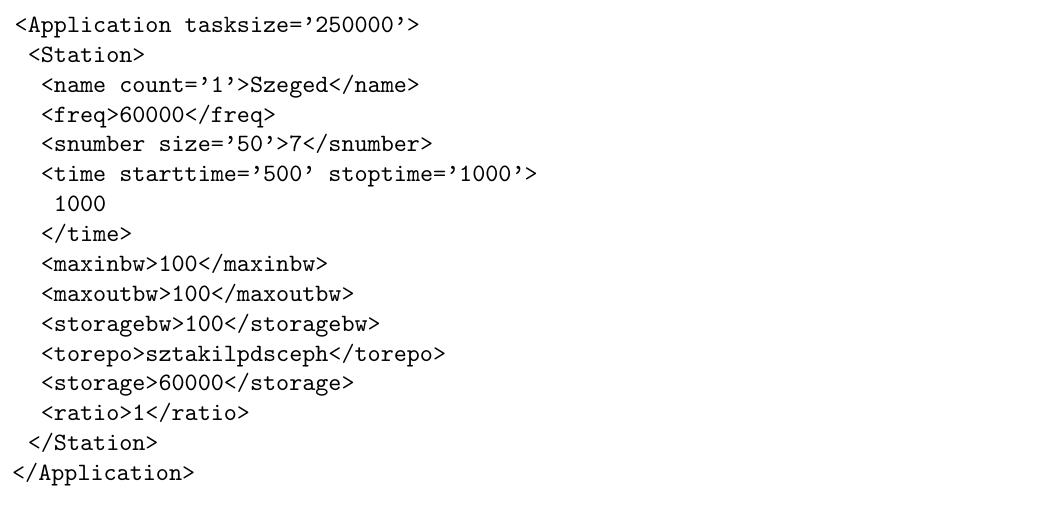
Figure 5. XML-based description of IoT